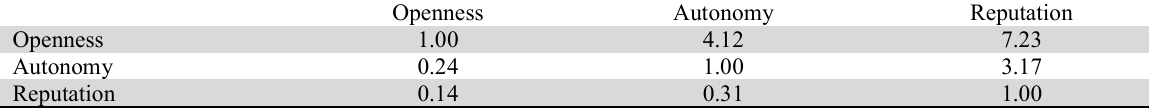
Comparison matrix for comparing the sub-factors of “MOOCs features”